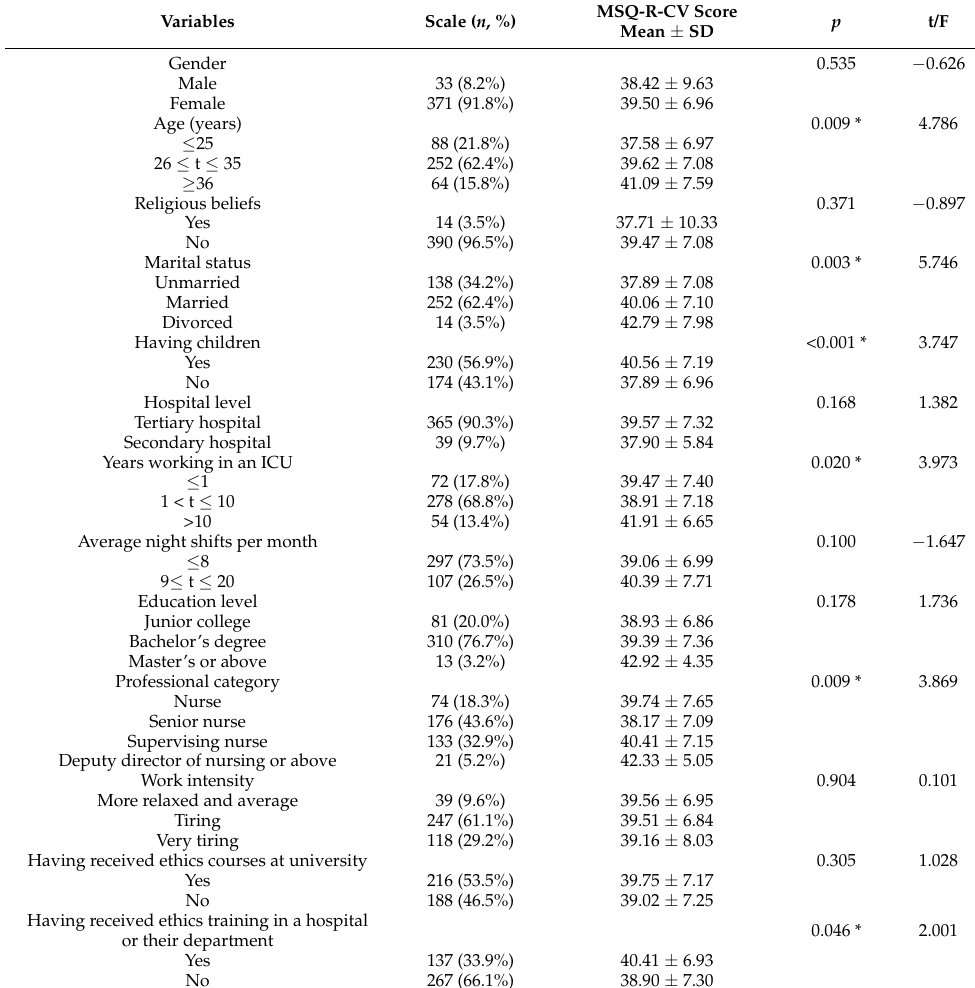
Table 1. Comparison of moral sensitivity scores across general socio-demographic characteristics.